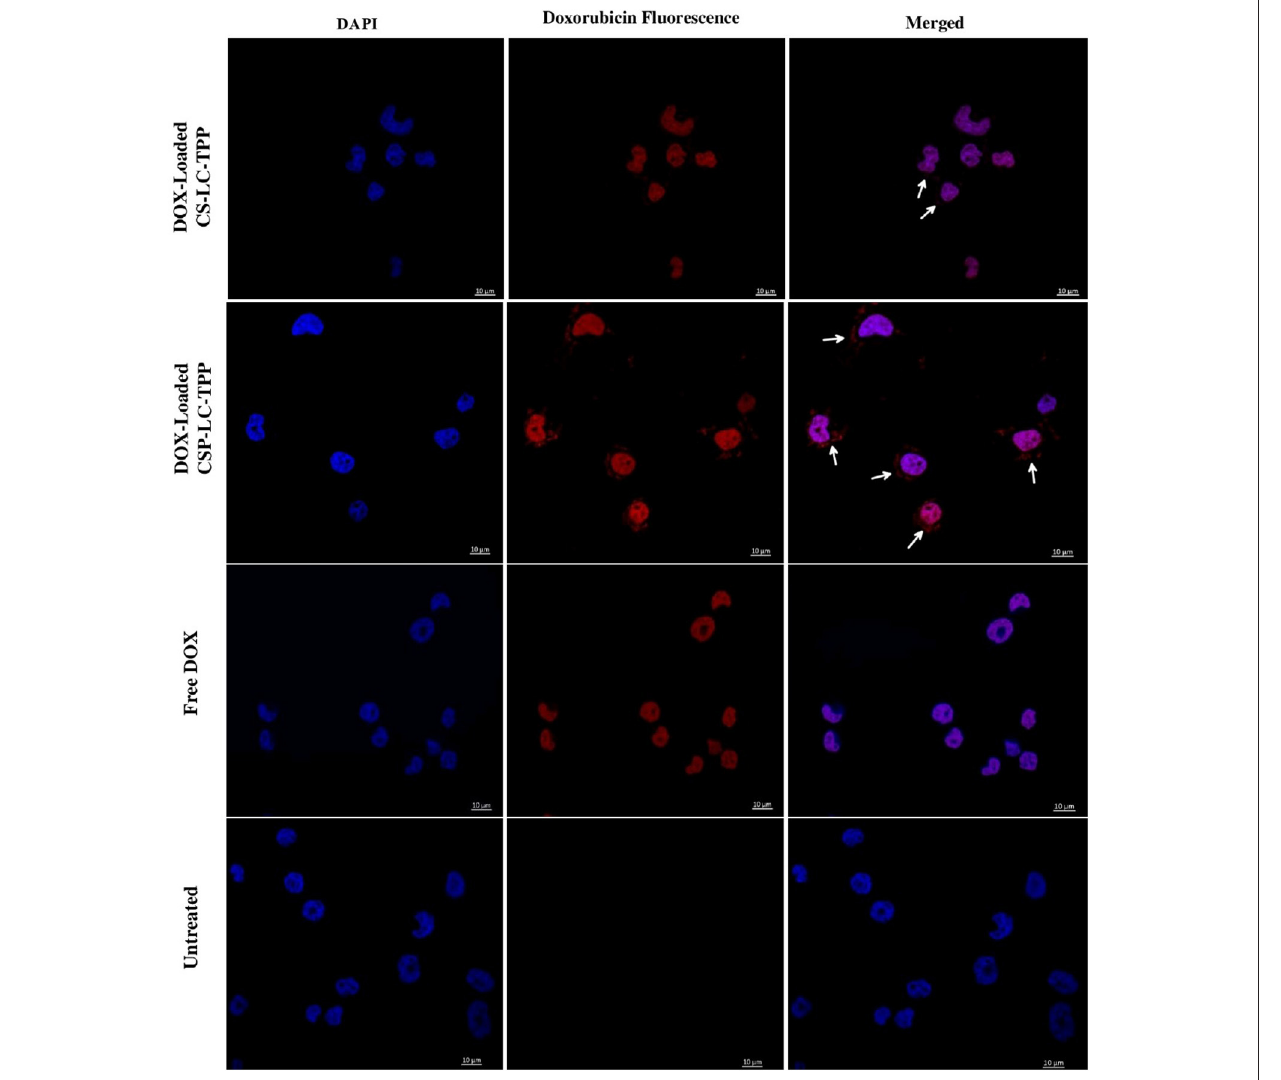
FIGURE 5 | Confocal fluorescence microscopy images showing MDA-MB-453 cancer cells treated with DOX-loaded CS-LC-TPP NPs, CSP-LC-TPP NPs, free DOX, and control (untreated) cells. All treatments are equivalent to 1 µ M doxorubicin over 4-h periods. White arrows point nanoparticles uptaken into cellular cytoplasm. Scale = 10 µ